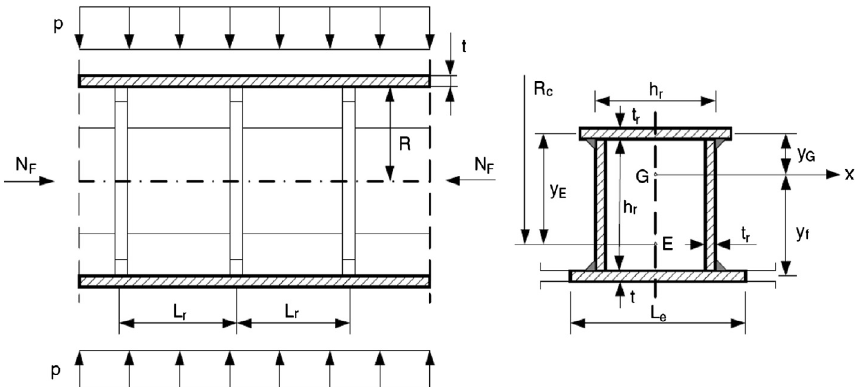
Figure 6. Orthogonally stiffened cylindrical shell with stringer and ring stiffener acted by compression and external pressure [21].